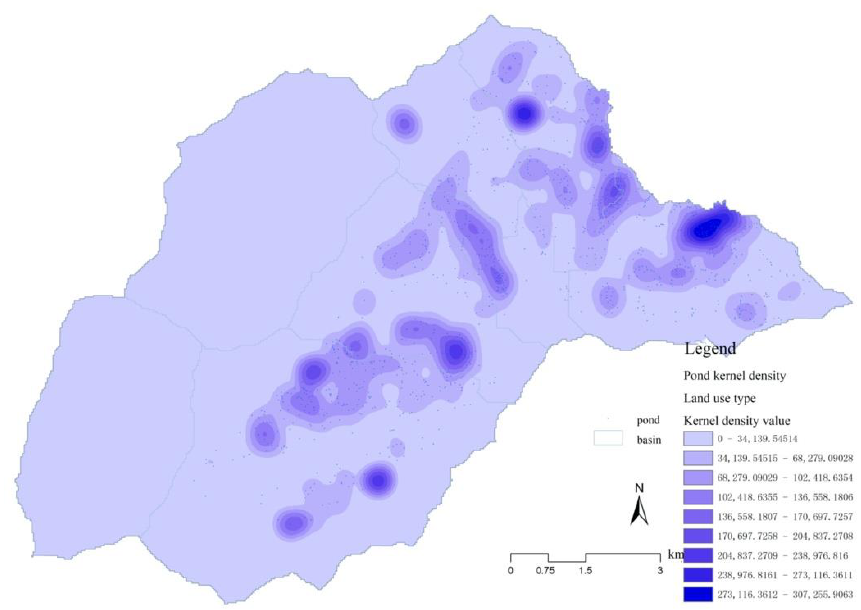
Figure 6. The density map for the Beitang landscape.